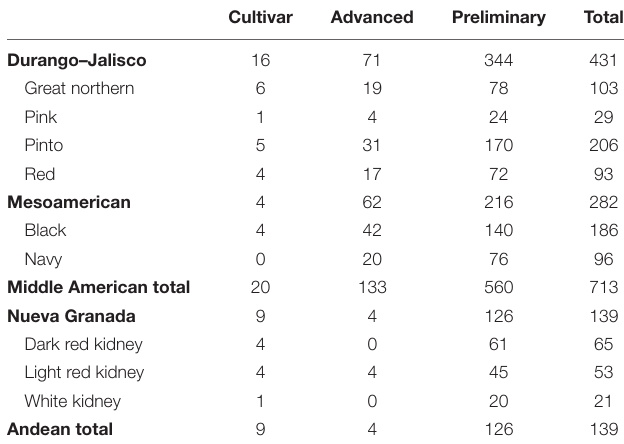
TABLE 1 | Gene pools, races, and market classes of cultivars and North Dakota State University advanced and preliminary breeding genotypes screened for resistance to common bacterial blight under greenhouse conditions and utilized for gene